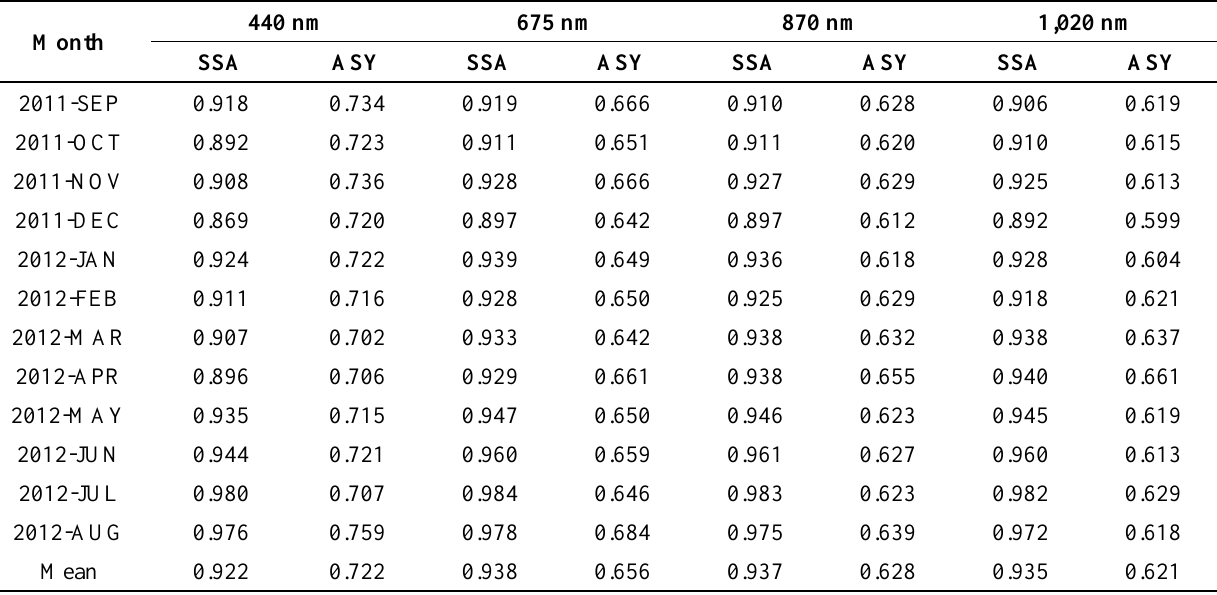
Table 1. Monthly mean single scattering albedo and asymmetry coefficient retrieved from the sun photometer measurements at the Lake Taihu